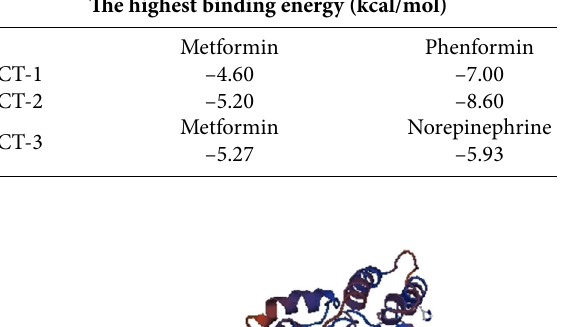
Table 2. The list of the best binding energy poses of metformin, phenformin, and norepinephrine, and hOCT1-3 proteins through